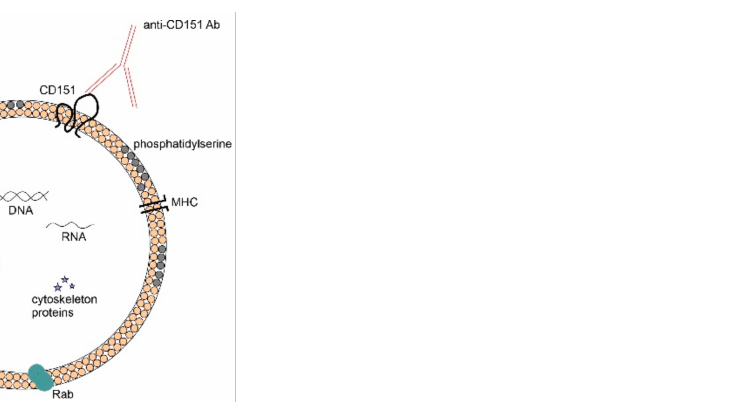
Figure 2. CD151 protein present in the membrane of the extracellular vesicle, which is a specific biomarker of prostate